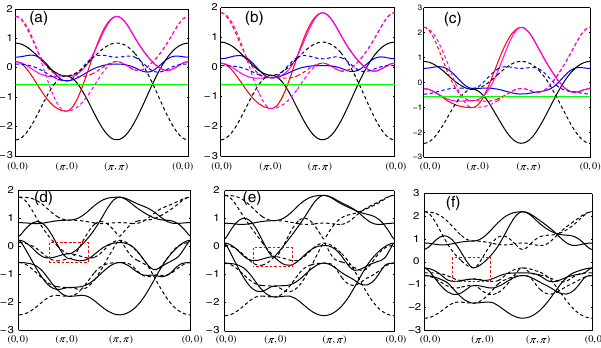
FIG. 2. (a) – (c) The band structures along high-symmetry lines for the case without interorbital hoppings. (a) The bulk case. 0 . 066 , t 14 0 . 405 , and (b) The adjusted parameters t 44 xy ¼ x ¼ − 0 . 120 . (c) t 44 0 . 036 , t 44 0 . 163 , t 14 0 . 405 , and t 11 x ¼ xy ¼ x ¼ x ¼ − 0 . 311 . The solid and dashed lines are from t 11 x ¼ A ð k Þ =A ð k þ Q Þ . The red, magenta, blue, black, and green lines =d =d =d =d are the d bands. (d) – (f) The cases with xz yz xy x 2 − y 2 z 2 interorbital hoppings, corresponding to (a) – red-dashed d band is pushed down and the blue-dashed xz d band is pushed up. The critical case is shown in xy Fig. 2(b); the two bands meet each other at the M point.